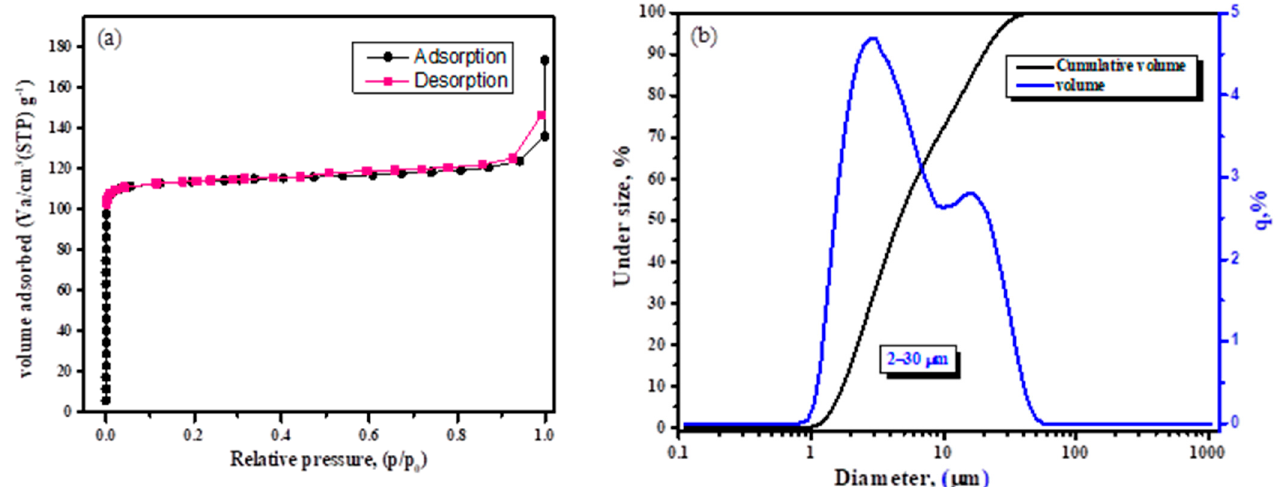
Figure 4. N 2 adsorption-desorption isotherms ( a ), particle size distribution of the synthesized zeolite ( b ).